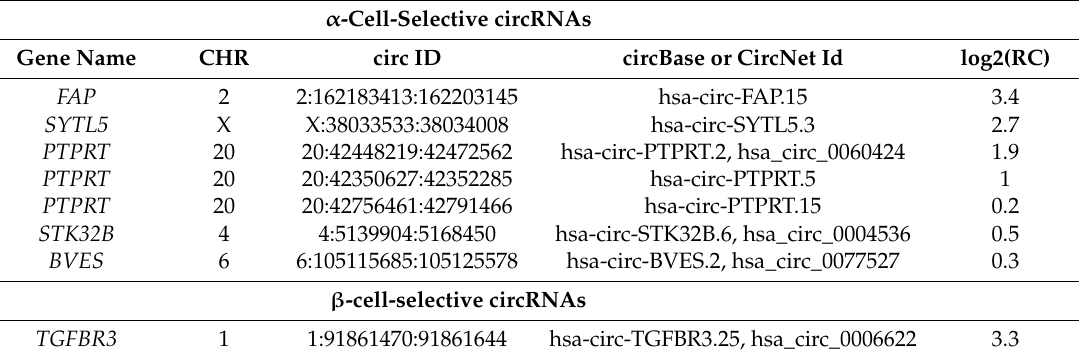
Table 6. Highly selective α - and β -cell circRNAs are highlighted based on the overlap with integrated ATAC-seq and mRNA-seq analysis from